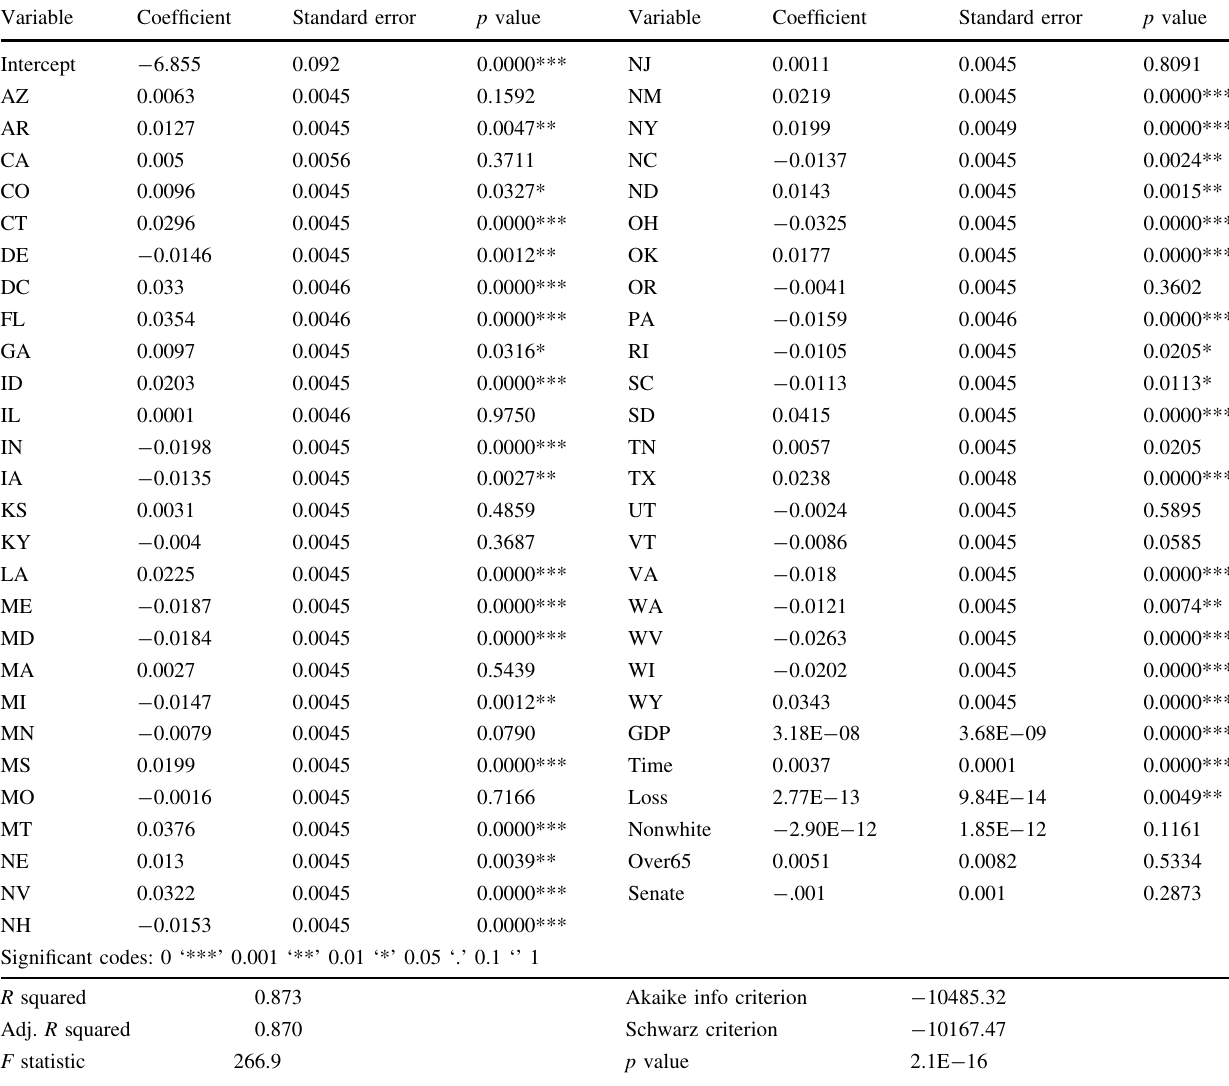
Table 2 State-specific fixed effects model results for the United States for the period